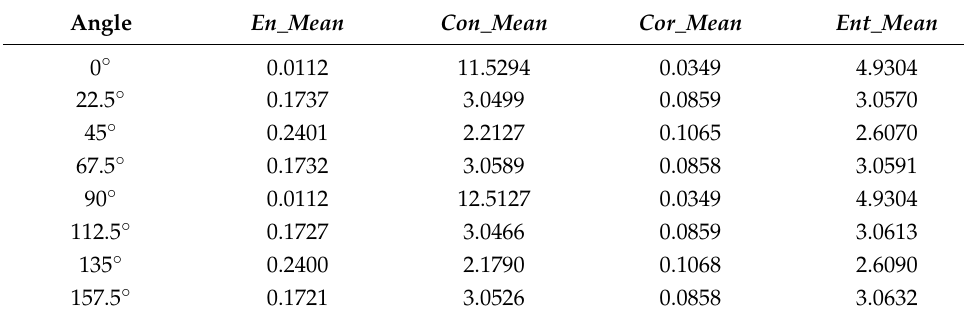
Table 8. Result of EGLCM with different angles.